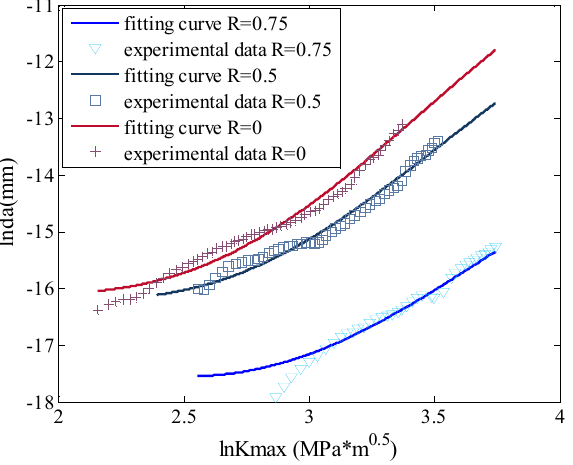
Figure 15. The fitting by ANN vs. the testing data for D16 aluminum alloy.